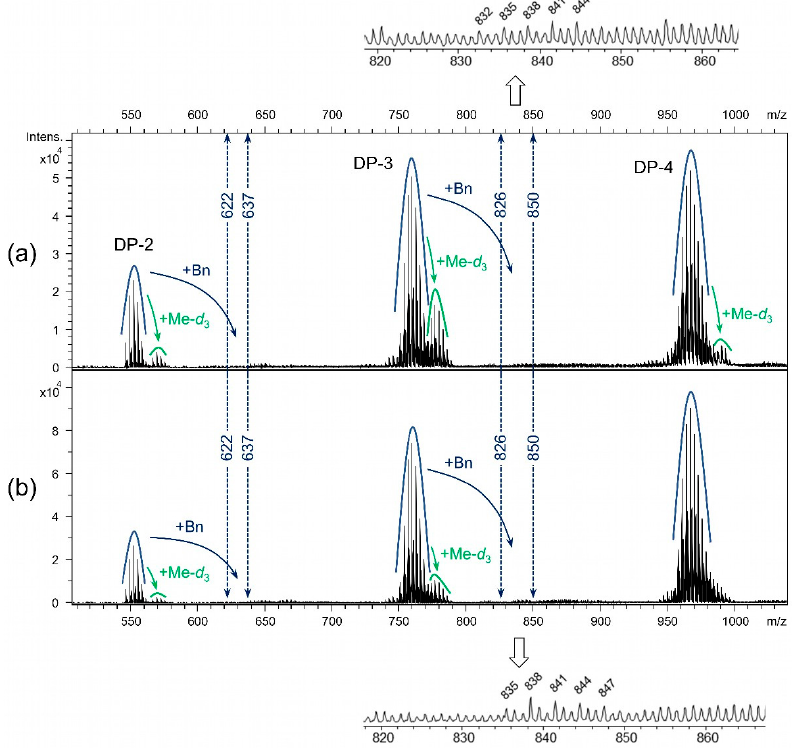
Figure 9. A cutout of the LC-MS spectra (negative ion mode) of ( a ) deBnMC-3 (Method-2c, Table 1) and ( b ) deBnMC-3* (Na/NH 3 , Method-3, Table 1), after deuteromethylation, partial hydrolysis, and labeling with m -ABA. For details refer to the Materials and Methods Section 2.7.